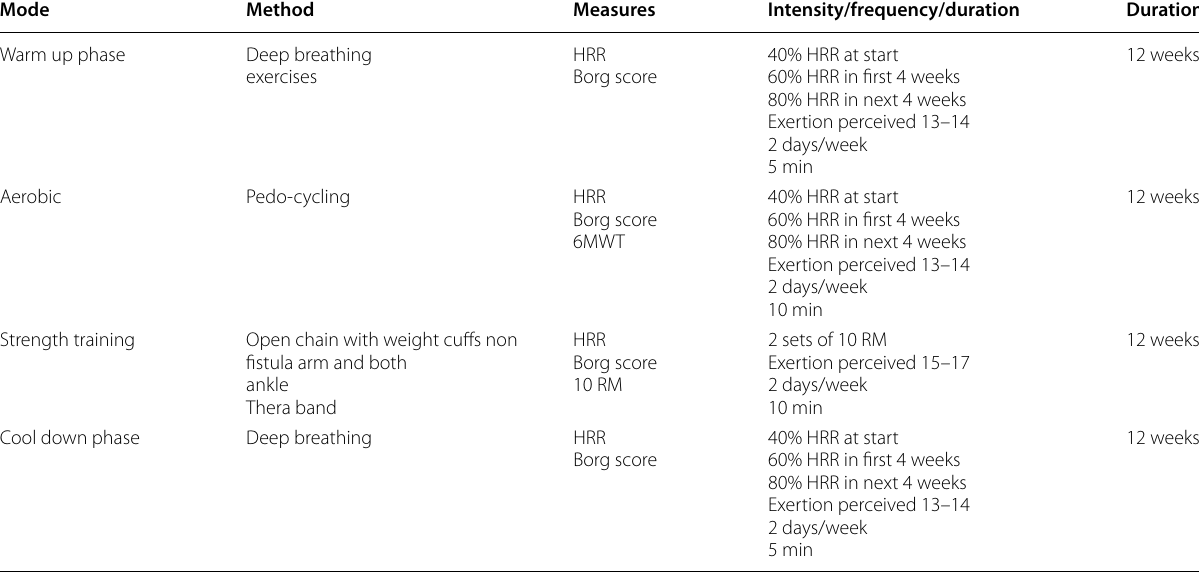
Table 1 Intradialytic exercises